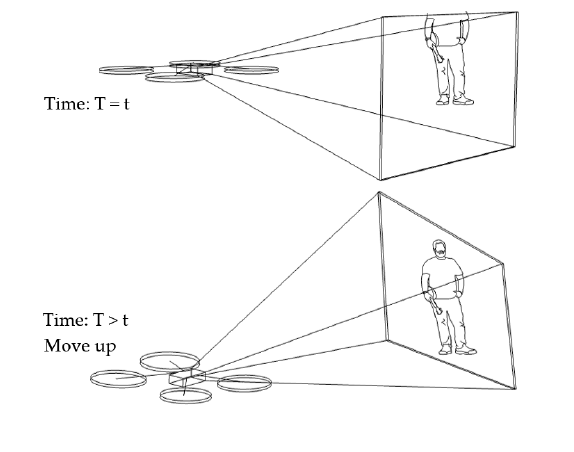
Figure 9. Human motion tracking when the drone moves up.